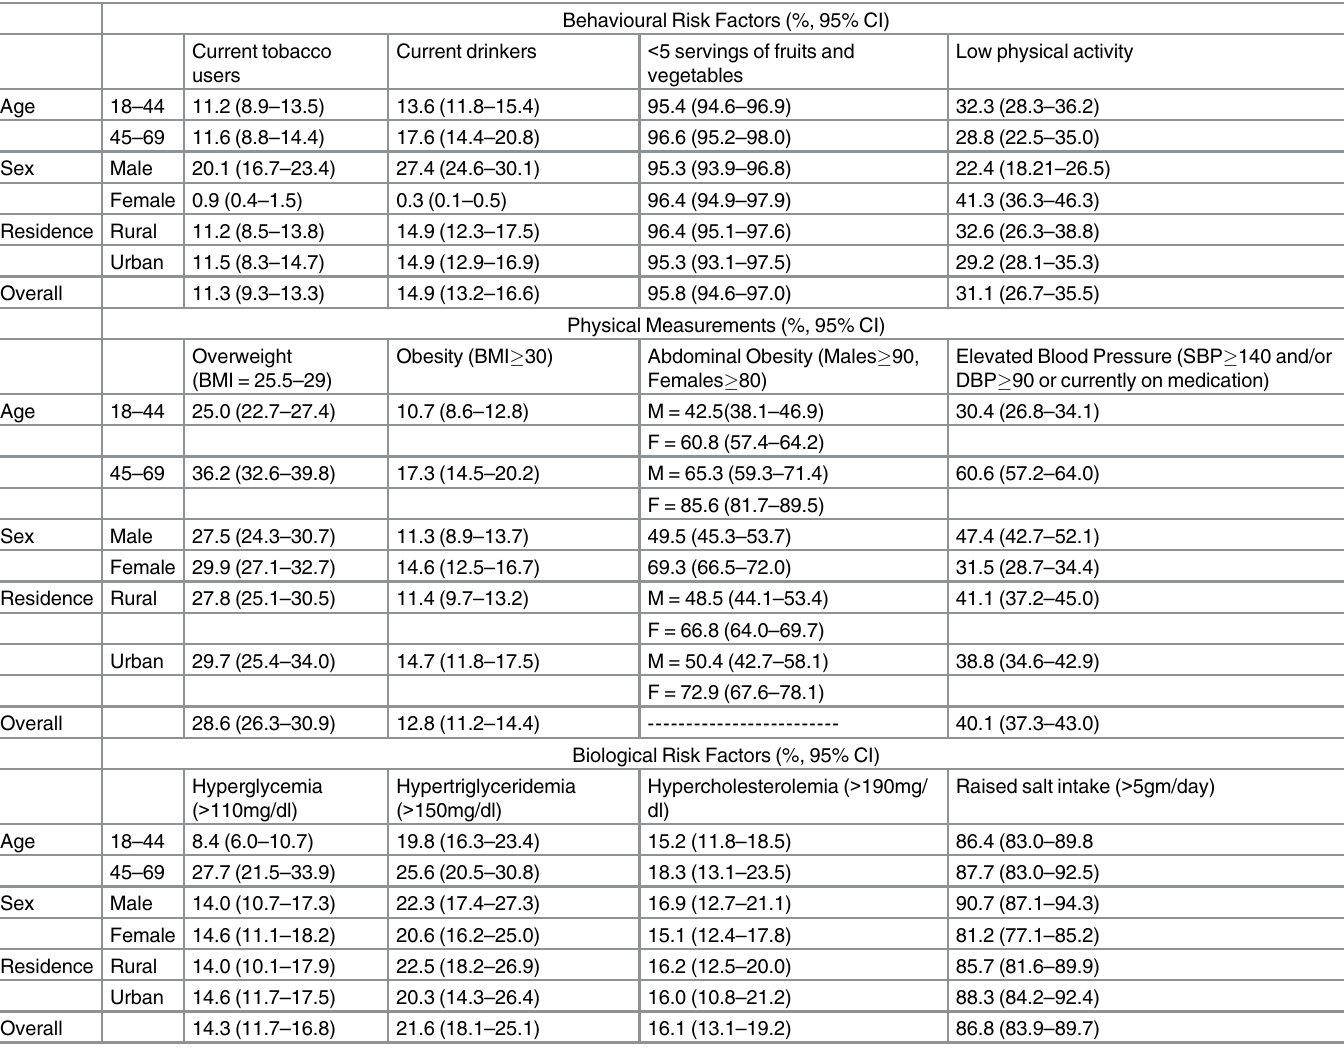
Table 2. Prevalence of Various NCD Risk Factors in Punjab State, Overall and Stratified by Age Group, Sex, and Residence (Rural/Urban), 2014 –